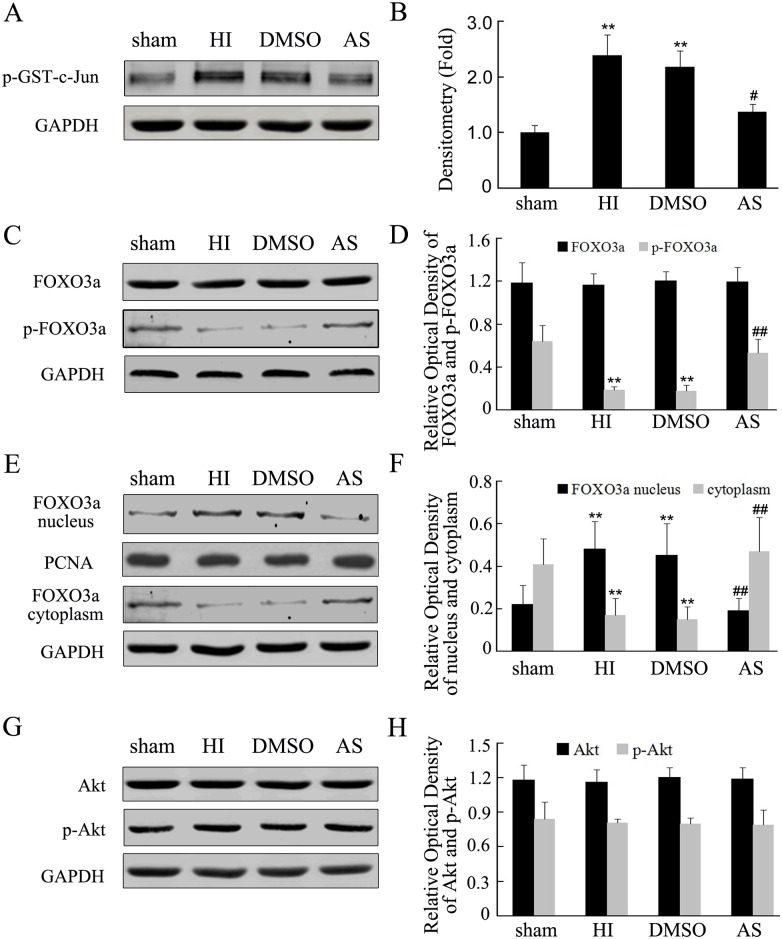
JNK inhibitor AS601245 significantly rescued the decrease in p-FOXO3a and attenuated FOXO3a translocation into nucleus after HI with no influence on p-Akt.Samples were obtained from the cortex. A JNK in vitro kinase assay showed a significant increase in phosphorylated GST-c-Jun (p-GST-c-Jun) in the cortex at 48 h after HI compared with sham controls (A). AS601245 pretreatment effectively blocked JNK activity at 48 h after HI compared with the DMSO-treated cortex (A). p-FOXO3a protein levels significantly increased with AS601245 pretreatment at 48 h after HI compared with the DMSO-treated cortex (C). However, total FOXO3a levels remained unchanged (C). Nuclear FOXO3a protein was reduced in the AS601245-treated cortex compared with the DMSO-treated cortex (E). In contrast, the cytosolic protein was increased in the AS601245-treated cortex compared with the DMSO-treated cortex (E). p-Akt and total Akt were not obviously changed at 48 h in the AS601245-treated cortex compared with the DMSO-treated cortex (G). Quantification of total FOXO3a, p-FOXO3a, FOXO3a nuclear, FOXO3a cytoplasmic, total Akt and p-Akt expression in sham controls, HI, DMSO-, and AS601245-treated cortices (D, F, and H). The data were obtained by densitometry and normalized to GAPDH as the loading control. The values are expressed in relative optical density and represented as the mean±SD. For each column, n = 5, *p<0.05, **p<0.01 versus the sham control, #p<0.05, ##p<0.01 compared with DMSO controls (HI, hypoxia-ischemia; AS, AS601245).